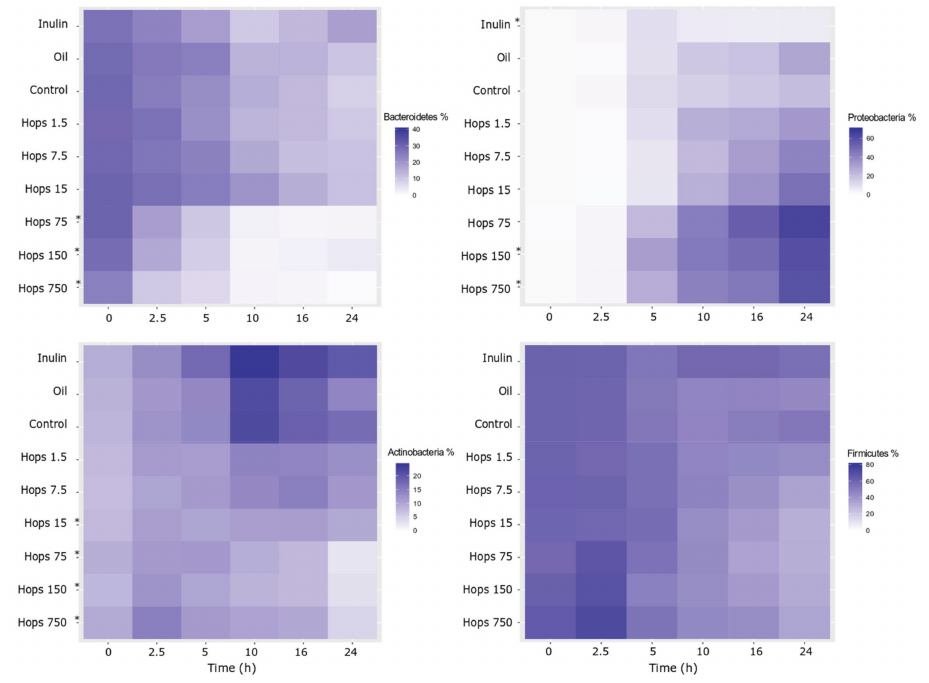
Figure 1. Heat plots depicting the four main phyla % relative abundance changes over time and sample type including hops concentration (mg). * p ≤ 0.05—Significantly di ff erent (average across all time points) compared with the control as determined by the Mann–Whitney–Wilcoxon test after false discovery rate correction.